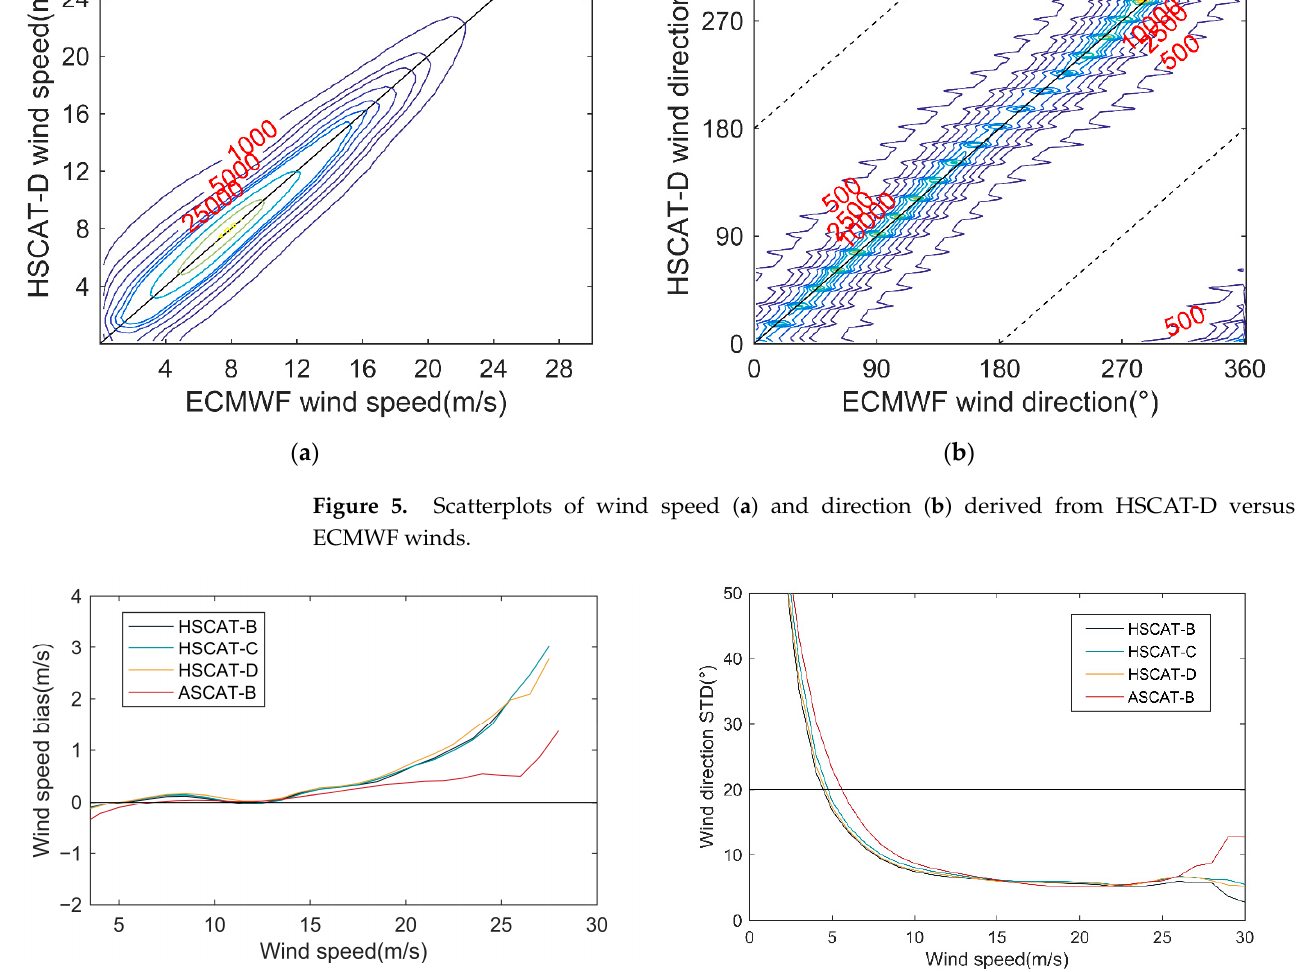
Figure 6. Wind speed bias as a function of average wind speed between scatterometers and model winds ( a ) and the standard deviation of wind direction difference between scatterometers and ECMWF as a function of average wind speed ( b ).